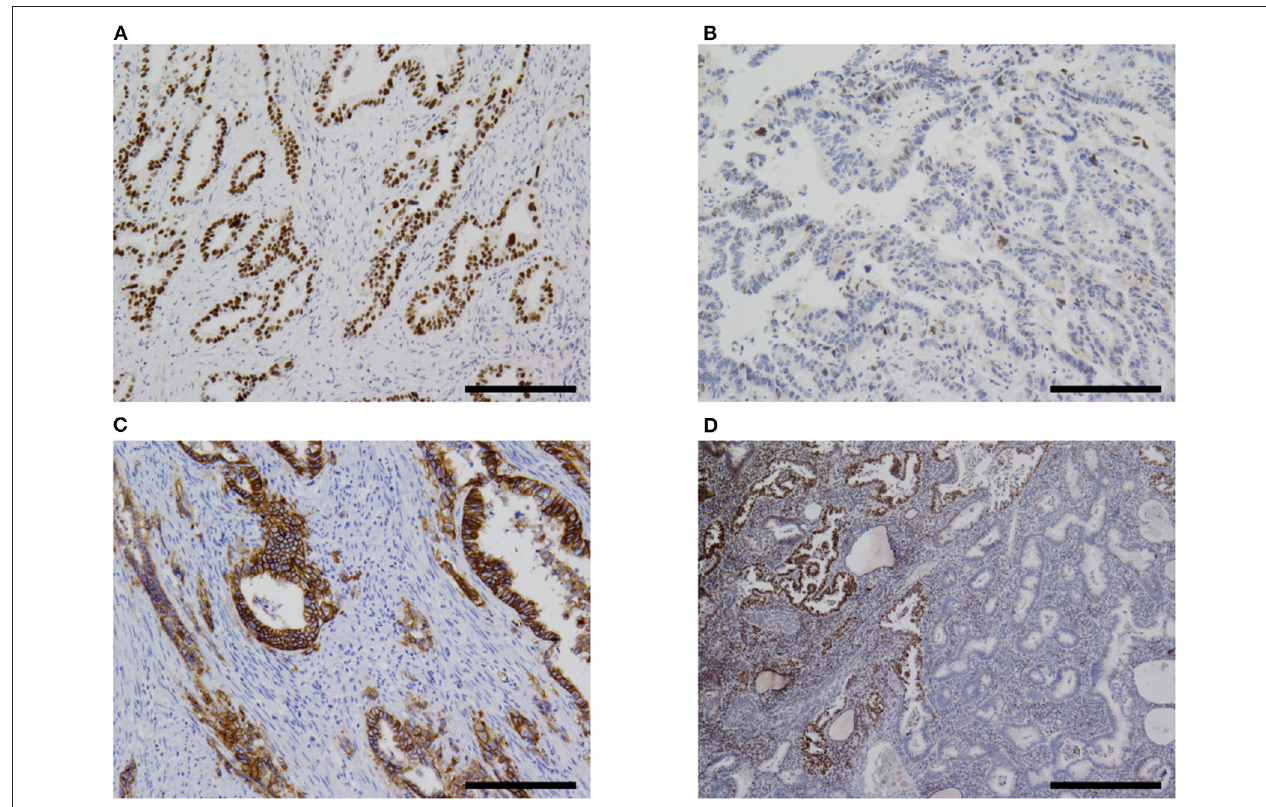
FIGURE 6 | Immunohistochemistry. (A) Most cases of α -fetoprotein-producing endometrial carcinoma were p53-aberrant on immunohistochemistry (case 5 shown). (B) Only one case in our series was p53-wildtype (case 4). (C) Some overexpressed HER2 (case 5). (D) One case (case 2) in our series showed subclonal loss of expression of MLH1 and PMS2 (not shown). Original magnification × 100 (A–C) and × 40 (D) , scale bars = 200 µ m (A–C) and 500 µ m (D)